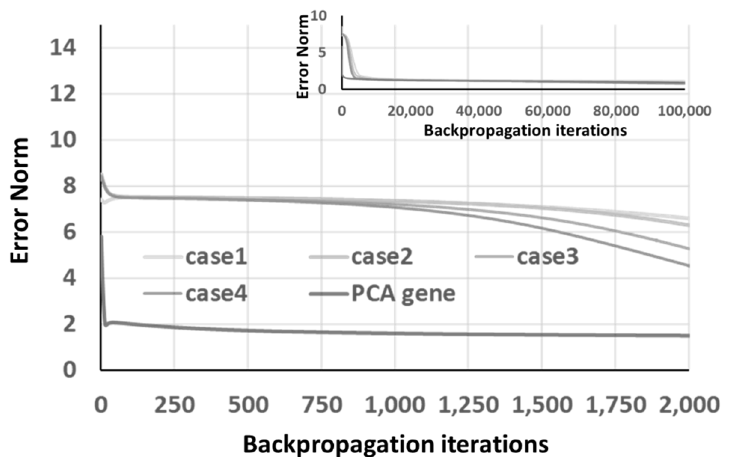
Figure 15. The convergence of 4 GA “back-to-original” optimized chromosomes and PCA gene under ANN architecture.